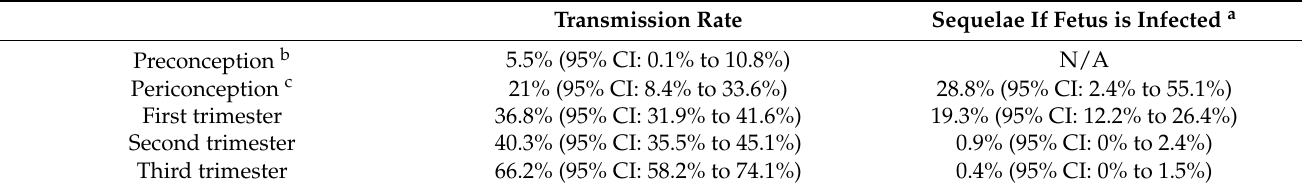
Table 1. Pooled rate of vertical transmission and fetal sequelae according to gestational age at the onset of primary infection (from Chatzakis et al. 2020) [146]. Transmission Rate Sequelae If Fetus is Infected